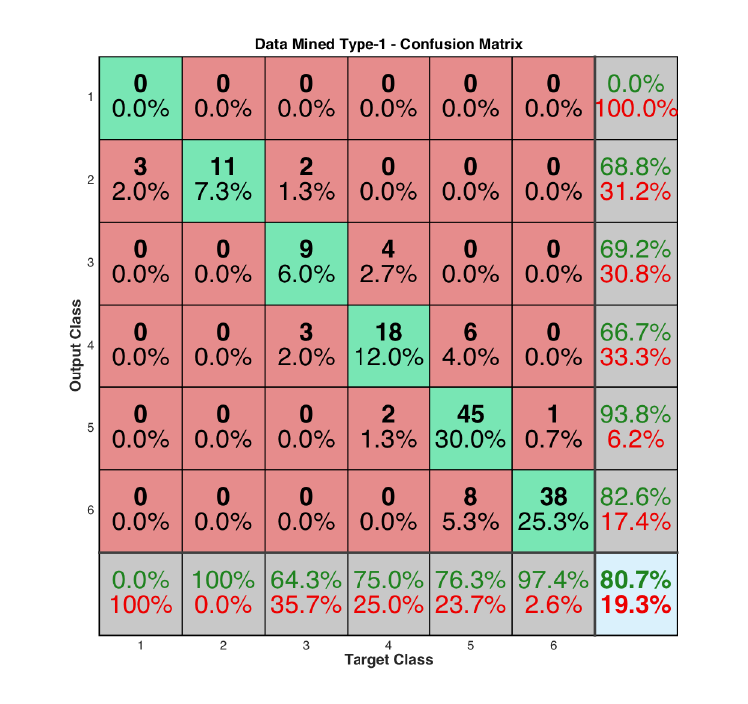
Figure 9. Confusion Matrix of the Data Mined Type-1 (DMT1F)